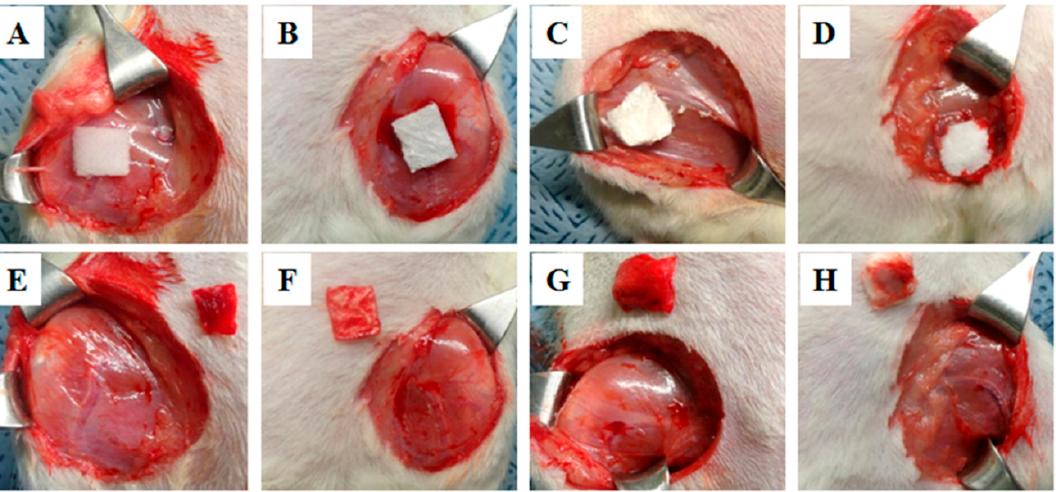
Figure 5. Hemostatic effect of SF-based sponges in a femoral artery wound of rat model. ( A , E ) Avitene, ( B , F ) Duck’s feet collagen (DFC), ( C , G ) Silk and ( D , H ) DFC/Silk [62].